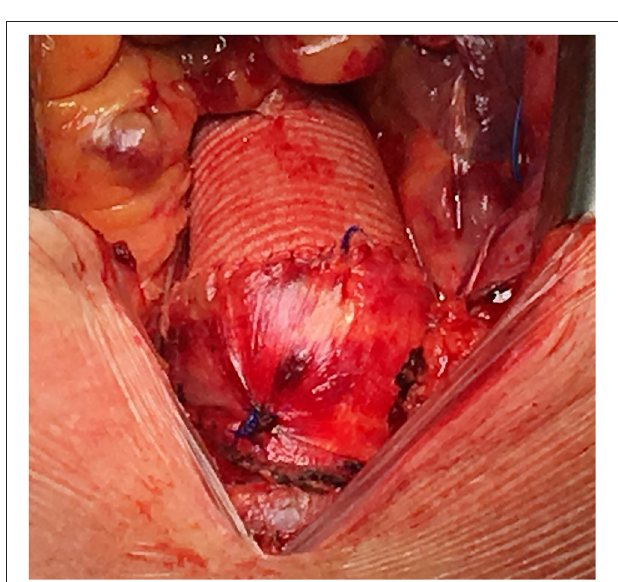
FIGURE 3 | Post-operative finding after aortic valve implantation and ascending aorta